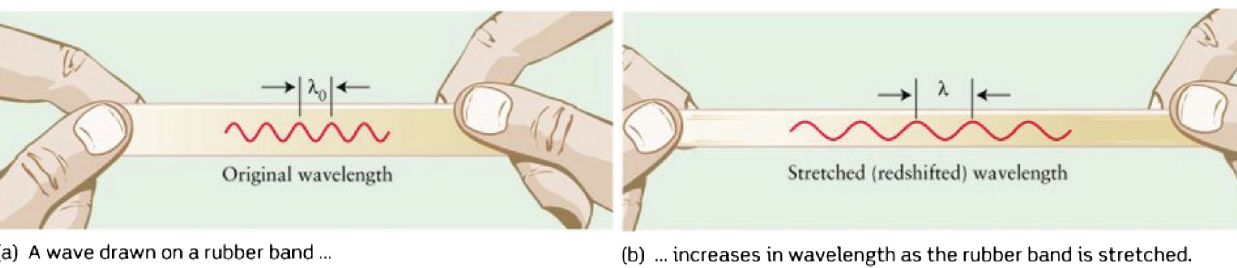
FIG. 21. Another variation of the representational analogy showing an expanding Universe. Image credit: Fraknoi et al. [102].